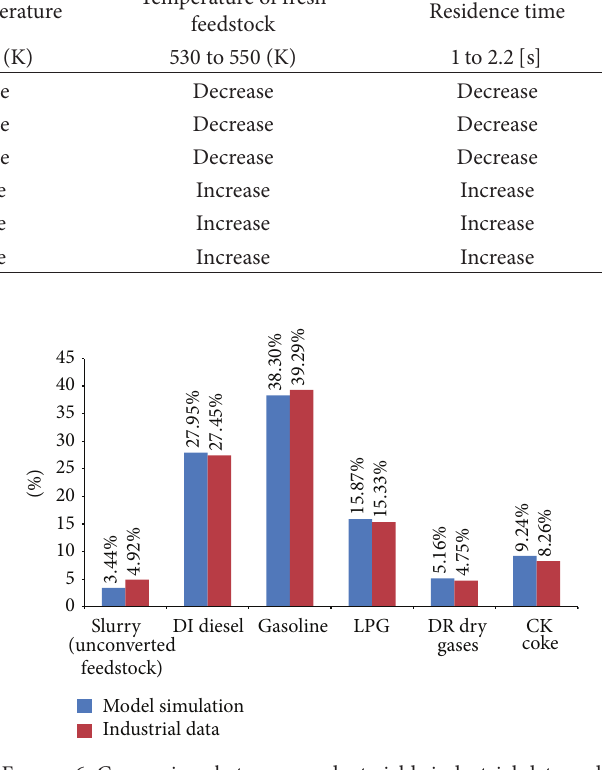
Figure 6: Comparison between product yields industrial data and the simulation model.